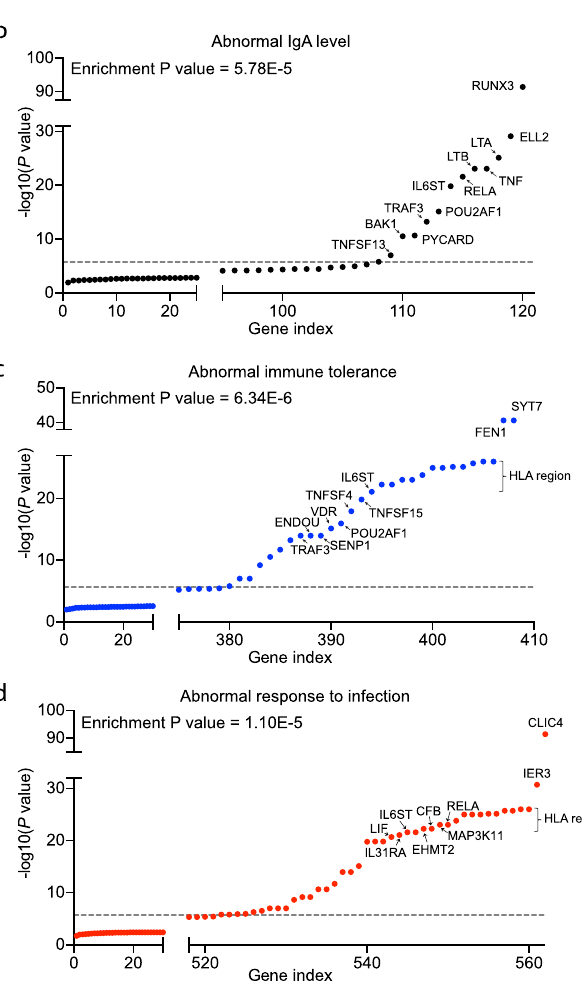
Fig. 3 | Pathway and gene set enrichment analyses. a Pathway enrichment ana- lysis for genes at the signi fi cant GWAS loci (two-sided enrichment test P -values). b Gene-set enrichment for genes that cause abnormal IgA level. c abnormal immune tolerance; and ( d ) abnormal response to infection when genetically manipulated in mice. The y -axis shows the fi xed effects meta-analysis – log10